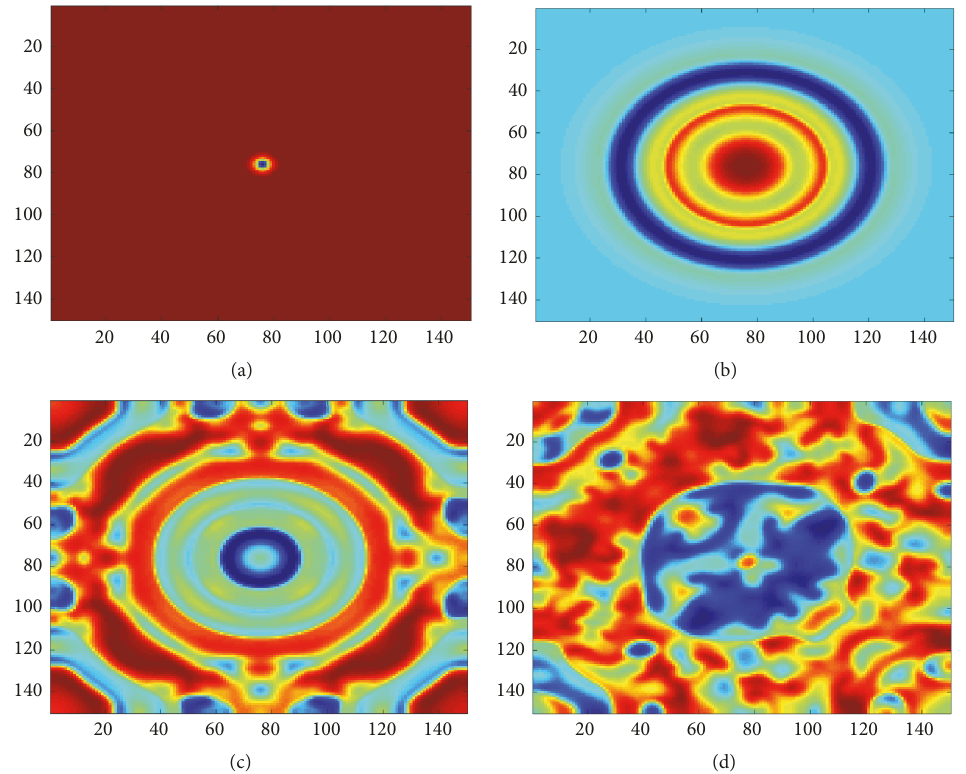
Figure 8: The snapshots of spatial distribution of membrane potential with color scale for neurons in the square array network for 𝑘 = 0.8 and 𝐷 = 5 at (a) 𝑡 = 2 time units, (b) 𝑡 = 75 time units, (c) 𝑡 = 135 time units, and (d) 𝑡 = 300 time